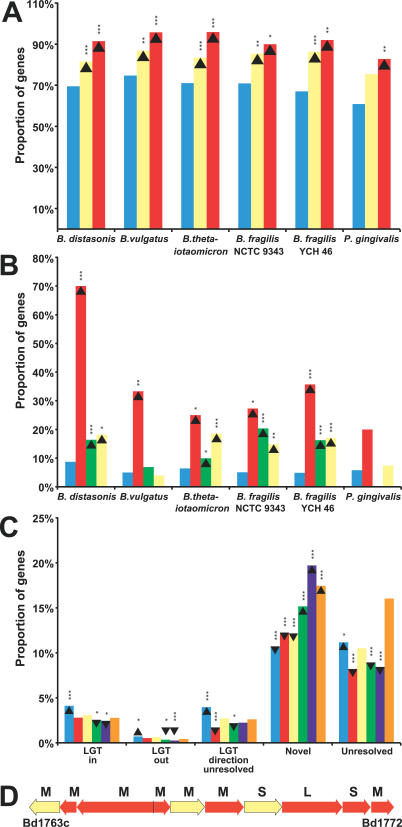
Analyses of Lateral Gene Transfer Events in Bacteroidetes Lineages Reveal Its Contribution to Niche Specialization(A) Genes involved in core metabolic processes are enriched among non-laterally transferred genes identified by a phylogenetic approach (see Materials and Methods). The proportion of genes identified as not laterally transferred in each genome (light blue), as well as assigned to the GO terms “Primary metabolism” (yellow) and “Protein biosynthesis” (red), are shown. Significant increases (enrichment) relative to each whole genome are shown by an upward-pointing arrowhead, and decreases (depletion) by a downward-pointing arrowhead, whereas the corresponding probability, determined by a binomial test, is denoted by asterisks: a single asterisk (*) indicates p < 0.05; double asterisks (**) indicate p < 0.01; and triple asterisks (***) indicate p < 0.001.(B) Laterally transferred genes are enriched among genes assigned to the GO term “DNA methylation” (e.g., restriction-modification systems) (red), relative to each complete genome (light blue). Glycosyltransferases (yellow) and genes located within CPS loci (green) are also enriched within the set of transferred genes. Significance was determined and denoted as in (A).(C) B. distasonis (light blue) possesses a significantly larger proportion of laterally transferred genes than the other Bacteroidetes, as shown by significant increases in the proportion of genes in each category of our analysis (“LGT in,” laterally transferred into the genome; “Novel,” no homologs identified from other species; “LGT direction unresolved,” laterally transferred but direction unknown; “LGT out,” laterally transferred out of the genome; and “Unresolved,” lateral transfer uncertain; see Materials and Methods for detailed explanations of categories and http://rd.plos.org/pbio.0050156.a for a complete list of genes in each category). Significant changes, denoted as in (A), were determined by a binomial test, using the average proportion within all other genomes used in the analysis as the reference. Other strains are B. vulgatus (red), B. thetaiotaomicron (yellow), B. fragilis NCTC 9343 (green), B. fragilis YCH 46 (purple), and P. gingivalis (orange).(D) A prominent laterally transferred locus within B. distasonis contains a ten-gene hydrogenase complex, likely allowing B. distasonis to use hydrogen as a terminal electron acceptor in anaerobic respiration. Genes transferred into B. distasonis are colored red, whereas genes whose phylogeny could not be resolved are shown in yellow. Letters indicate functional components of the hydrogenase complex: L, large subunit; M, maturation or accessory factor; and S, small subunit.